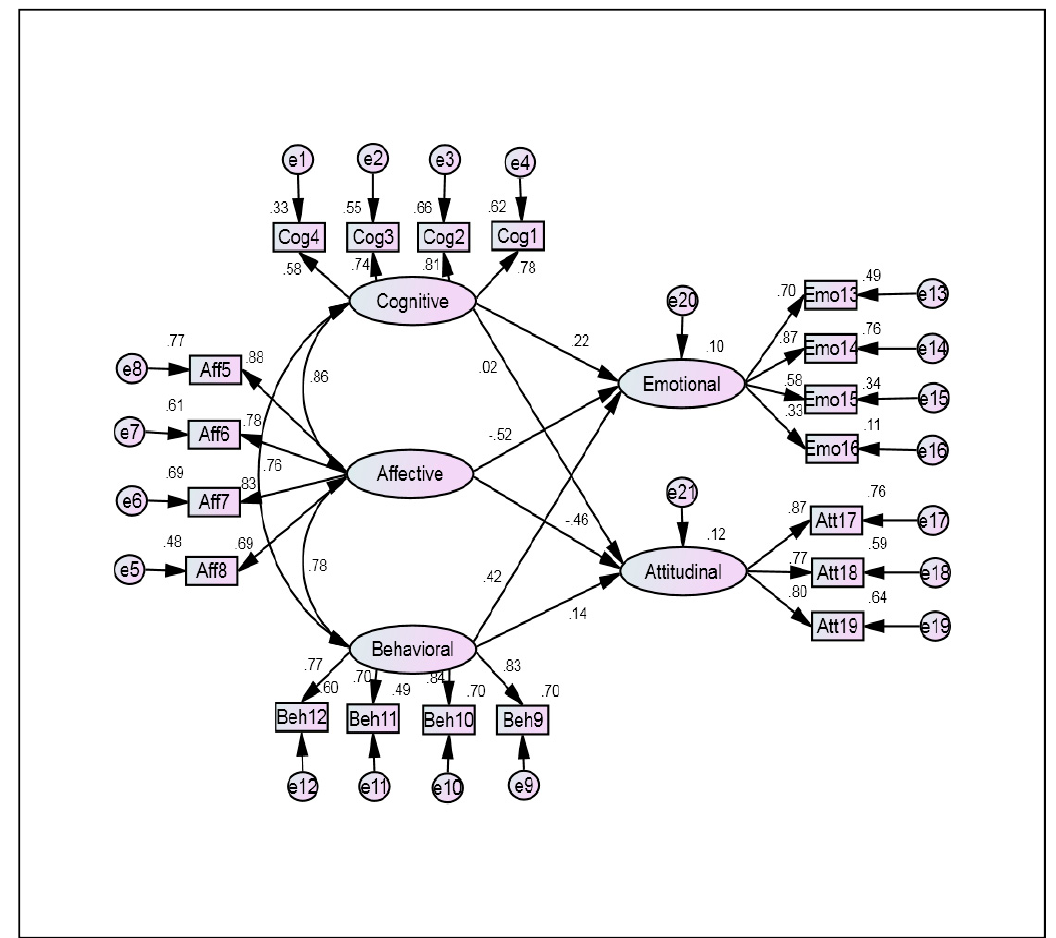
Figure 2. Structural equation model. Table 8. Hypothesis